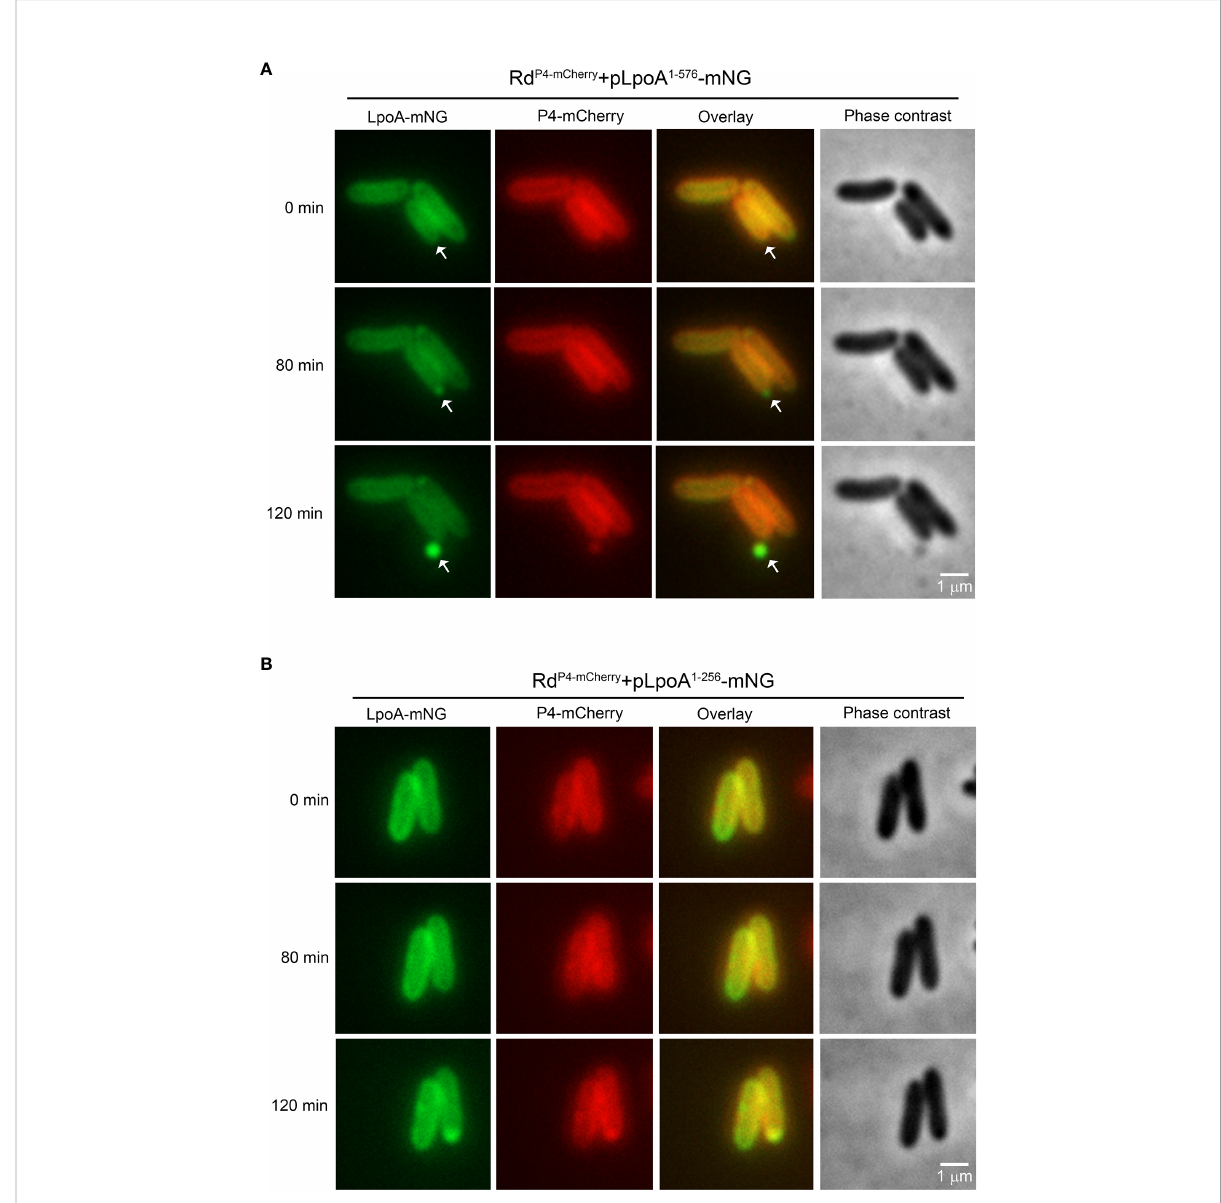
FIGURE 6 Time-lapse fl uorescence microscopy of H. in fl uenzae simultaneously producing the OM-retained P4-mCherry and two truncated LpoA- mNeonGreen variants. Bacteria were grown on solid CDM and induced by IPTG (100 µM). Phase contrast and fl uorescence channel images were captured with 10 min intervals. (A) H. in fl uenzae strain Rd P4 mcherry +pLpoA 1-576 -mNG accumulating full length LpoA in foci prior to inclusion into OMVs (white arrows). (B) No fl uorescent vesicles were released by H. in fl uenzae Rd P4 mcherry -pLpoA 1-256 -mNG expressing LpoA without the C-terminal (residues 257-576). All images were taken at 100x magni fi cation. Scale bars indicate 1